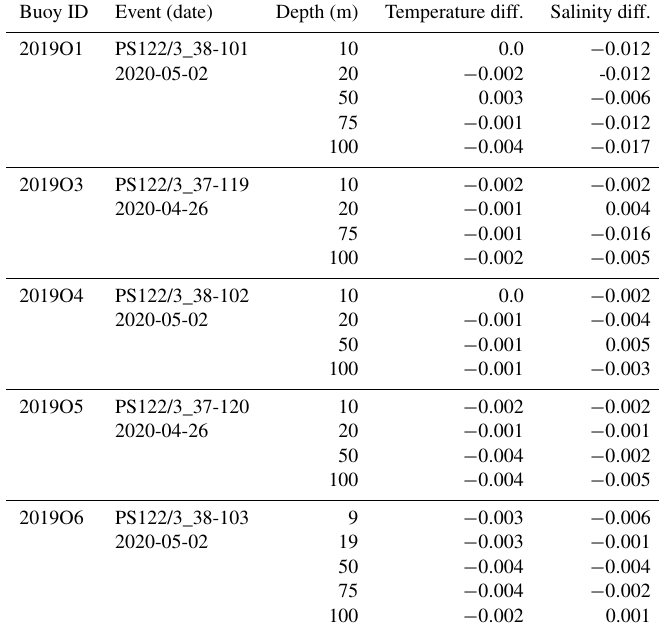
Table A1. Comparison of SST-CTD profiles with buoy measurements for